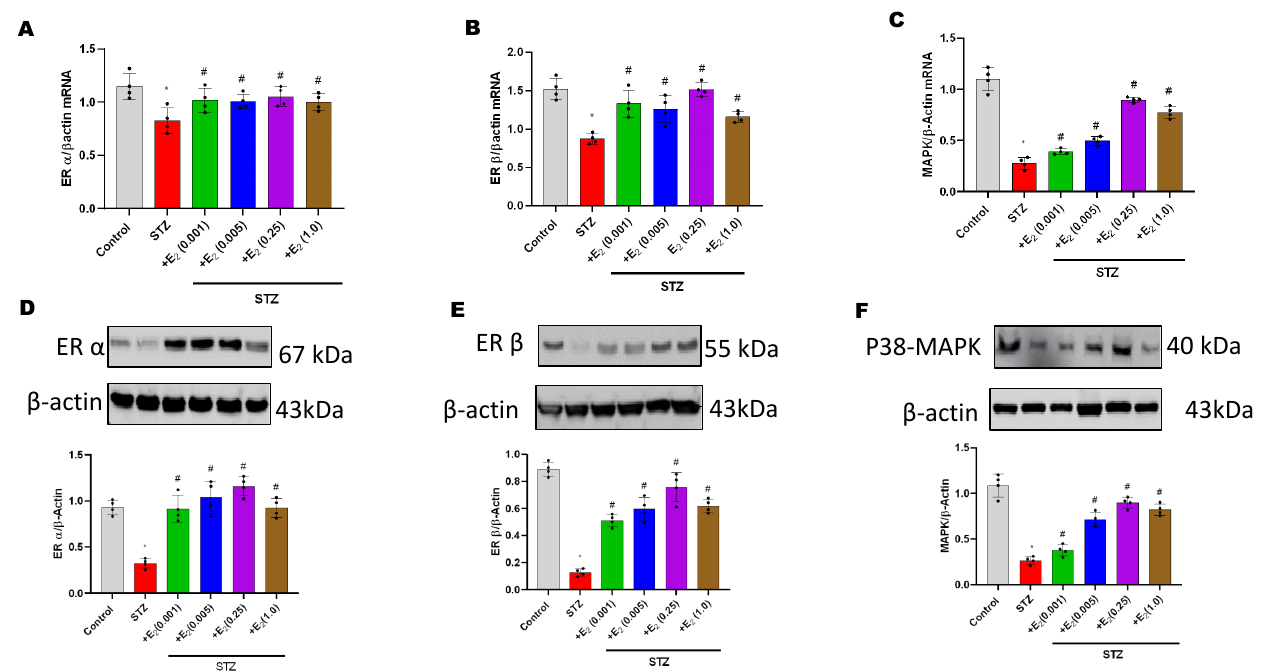
Figure 2. Effect of 17 β -estradiol (E 2 ) on mRNA and protein levels of estrogen receptor alpha (ER α ), estrogen receptor beta (ER β ), and phospho-MAPK in gastric neuromuscular tissues of STZ-induced diabetic mice. Total RNA was isolated from the gastric antral tissues. qRT-PCR was used to measure the level of each indicated mRNA ( A – C ). Data presented were normalized to mRNA levels of the housekeeping gene β -actin. Representative immunoblot and densitometry analysis for ER α ( D ), ER β ( E ), and p -MAPK ( F ) protein levels in gastric neuromuscular tissue samples are presented. Stripped blots were re-probed for β -actin. Densitometry data for target proteins were normalized to the protein levels of β -actin. Bar graphs depict the ratios between levels of target gene or protein to those of β -actin. Data were analyzed with one-way ANOVA using GraphPad Prism. Data